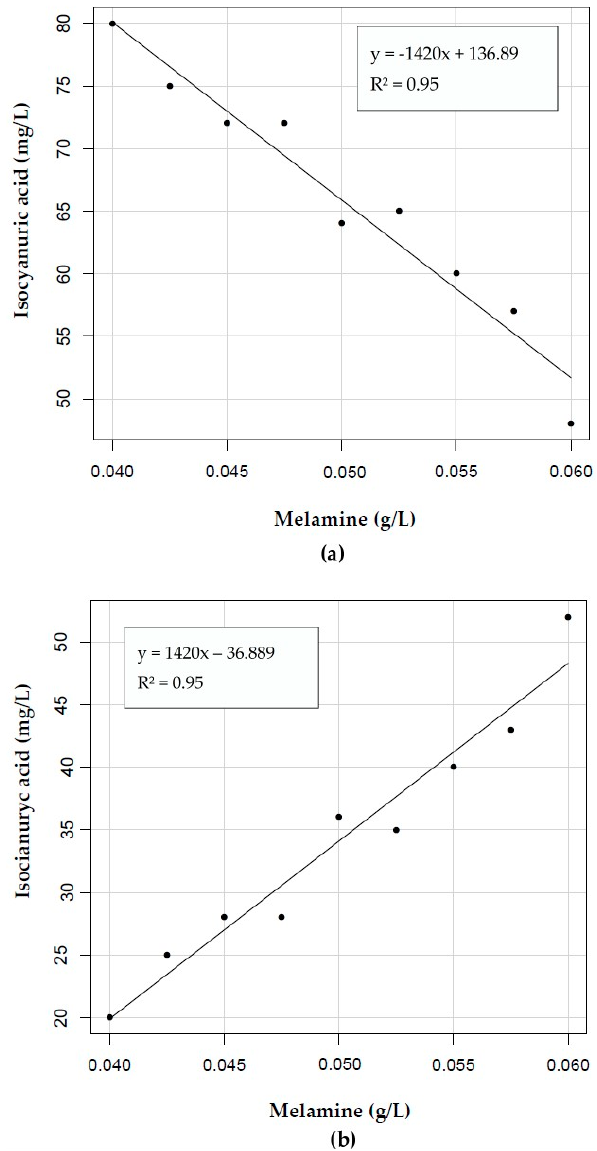
Figure 6. Range of doses of addition of melamine (0.04–0.06 g/L): ( a ) Variation of isocyanuric acid residual in the filtered water; ( b ) variation of isocyanuric acid removed in the filtered water.